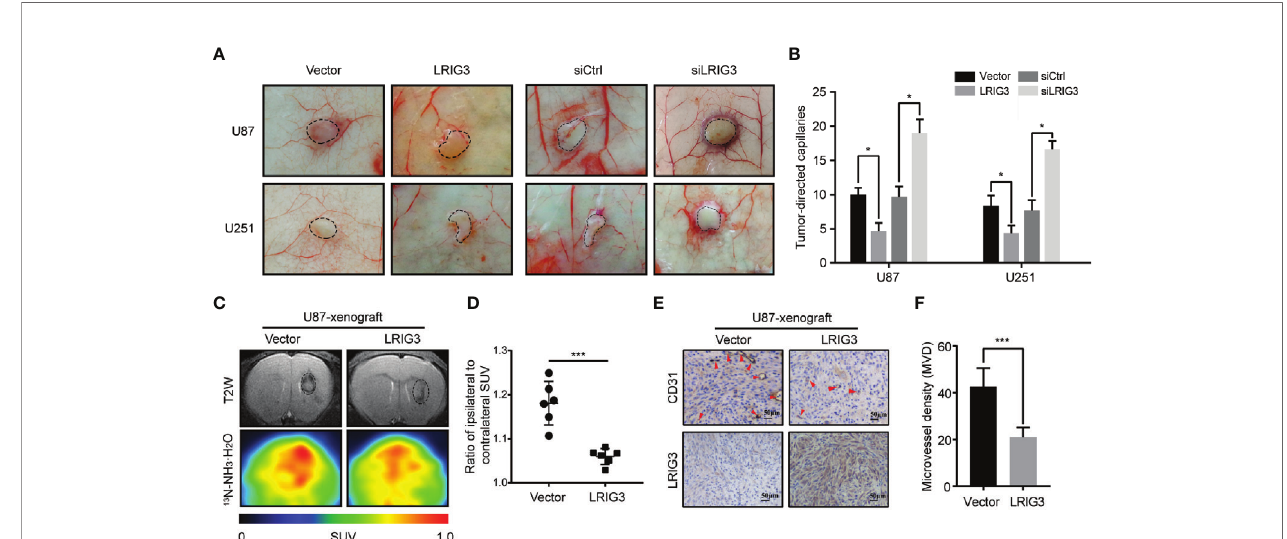
FIGURE 3 | LRIG3 affects the ability of gliomas to induce angiogenesis in vivo . Representative images (A) and quanti fi cation graphs (B) of the intradermal glioma tumors showing tumor-directed capillaries under different conditions: U87 and U251 cells transfected with the control vector and LRIG3; U87 and U251 cells transfected with the control and LRIG3 siRNAs. Dashed circles within the images show the tumor location. (C) Representative MRI and 13 NH 3 PET scan images of intracranial xenografts bearing LRIG3-overexpressing U87 cells or control cells, 14 days after tumor cell inoculation. (D) SUV ratio for the tumor to reference region (T/R) was used to determine the value for angiogenesis in the tumor, n = 6/group. (E) IHC analysis of LRIG3 and CD31 expression in intracranial xenografts generated from LRIG3-overexpressed U87 or control cells. (F) Quanti fi cation of CD31+ microvessel density in intracranial xenografts generated from LRIG3- overexpressed U87 or control cells. Data are means ± SD of 3 independent replicates. * p < 0.05; *** p < 0.001. MVD, microvessel density; PET, positron emission tomography; SUV, standardized uptake value; T/R, tumor/reference.